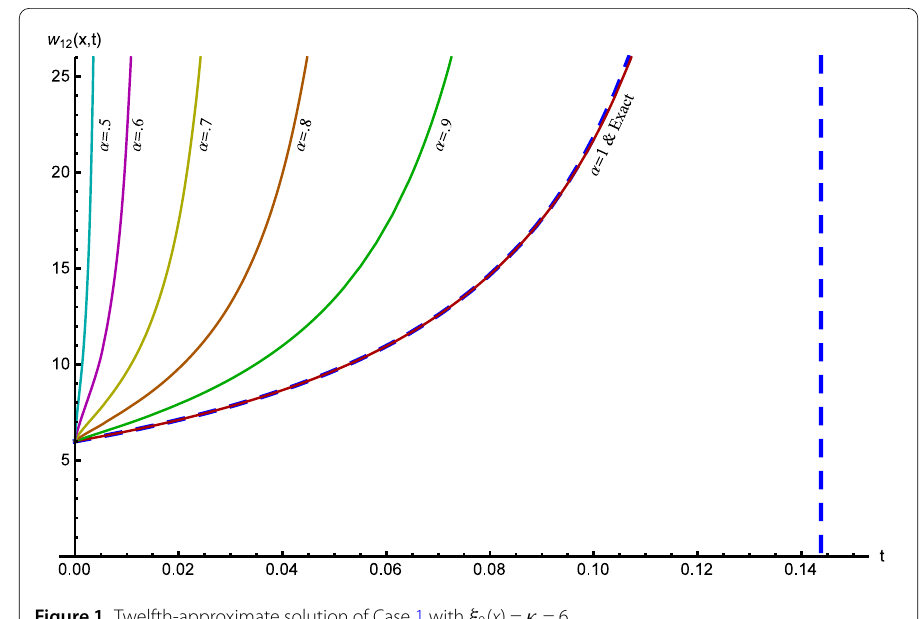
Figure 1 Twelfth-approximate solution of Case 1 with ξ 0 ( x ) = κ =